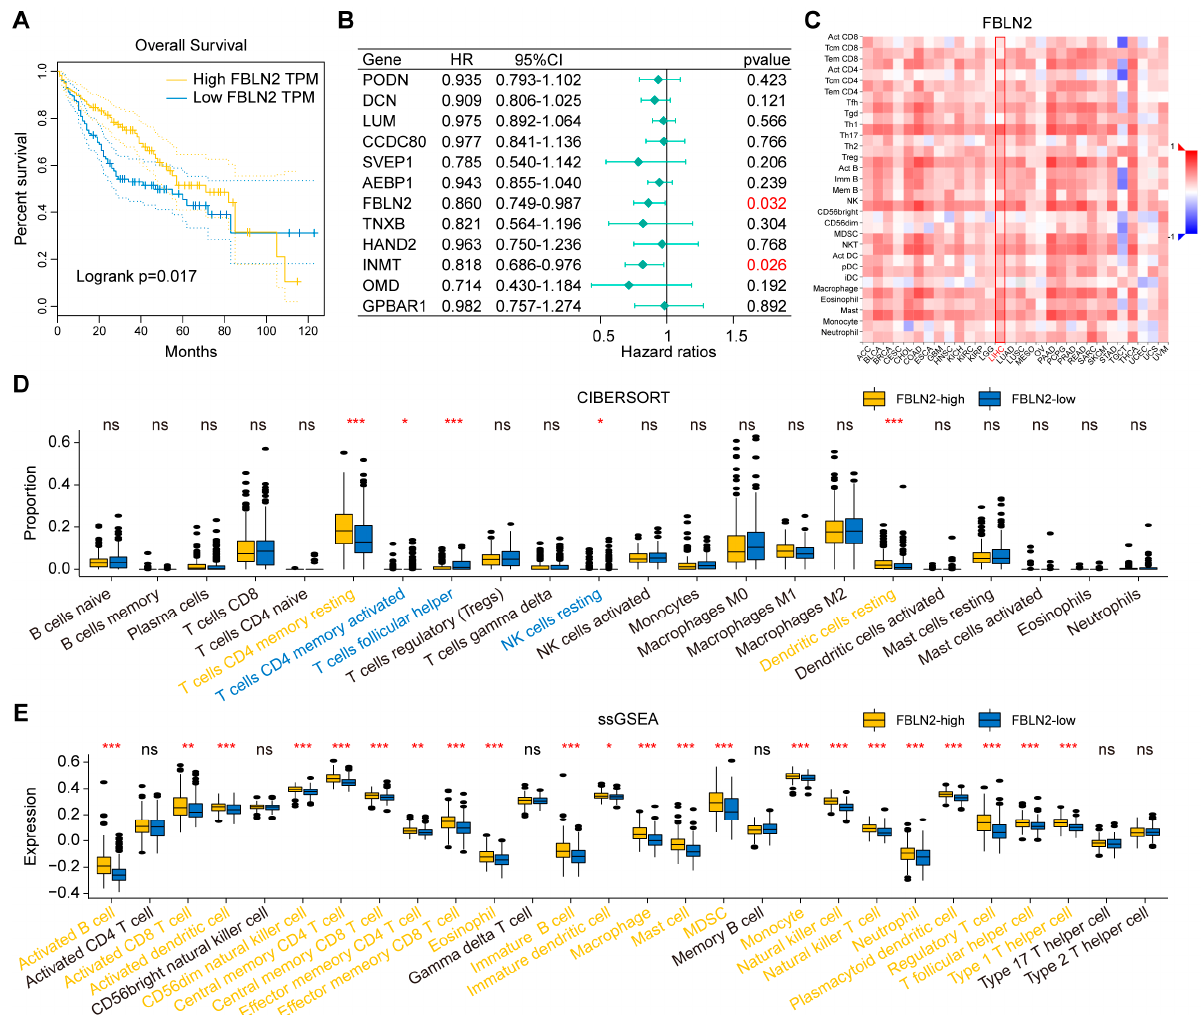
Figure 5. Determination of the functions of hub genes. ( A ) PPI network of hub genes. ( B ) Spearman rank correlation analysis among hub genes. ( C ) Correlation between hub genes and the stromal score, immune score, ESTIMATE score, and tumor purity of ESTIMATE. ( D ) Correlation analysis between hub genes and the expression of immune cells by ssGSEA.